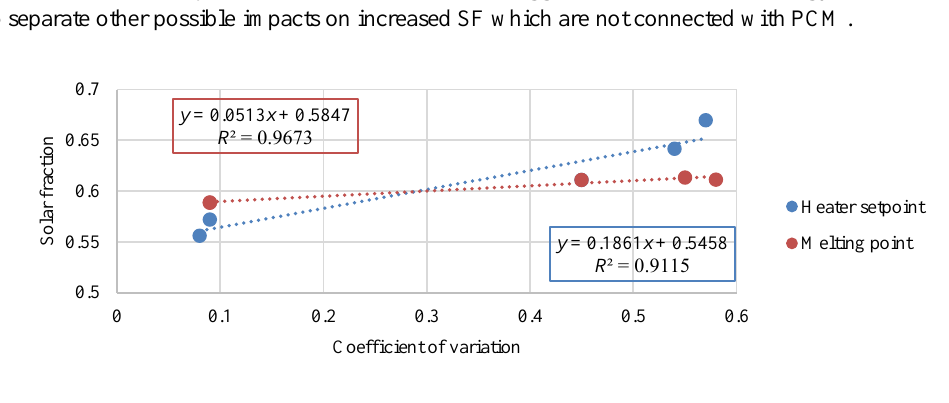
Fig. 10. Solar fraction correlation with the change of CV of energy in PCM for variances of melting point and heater